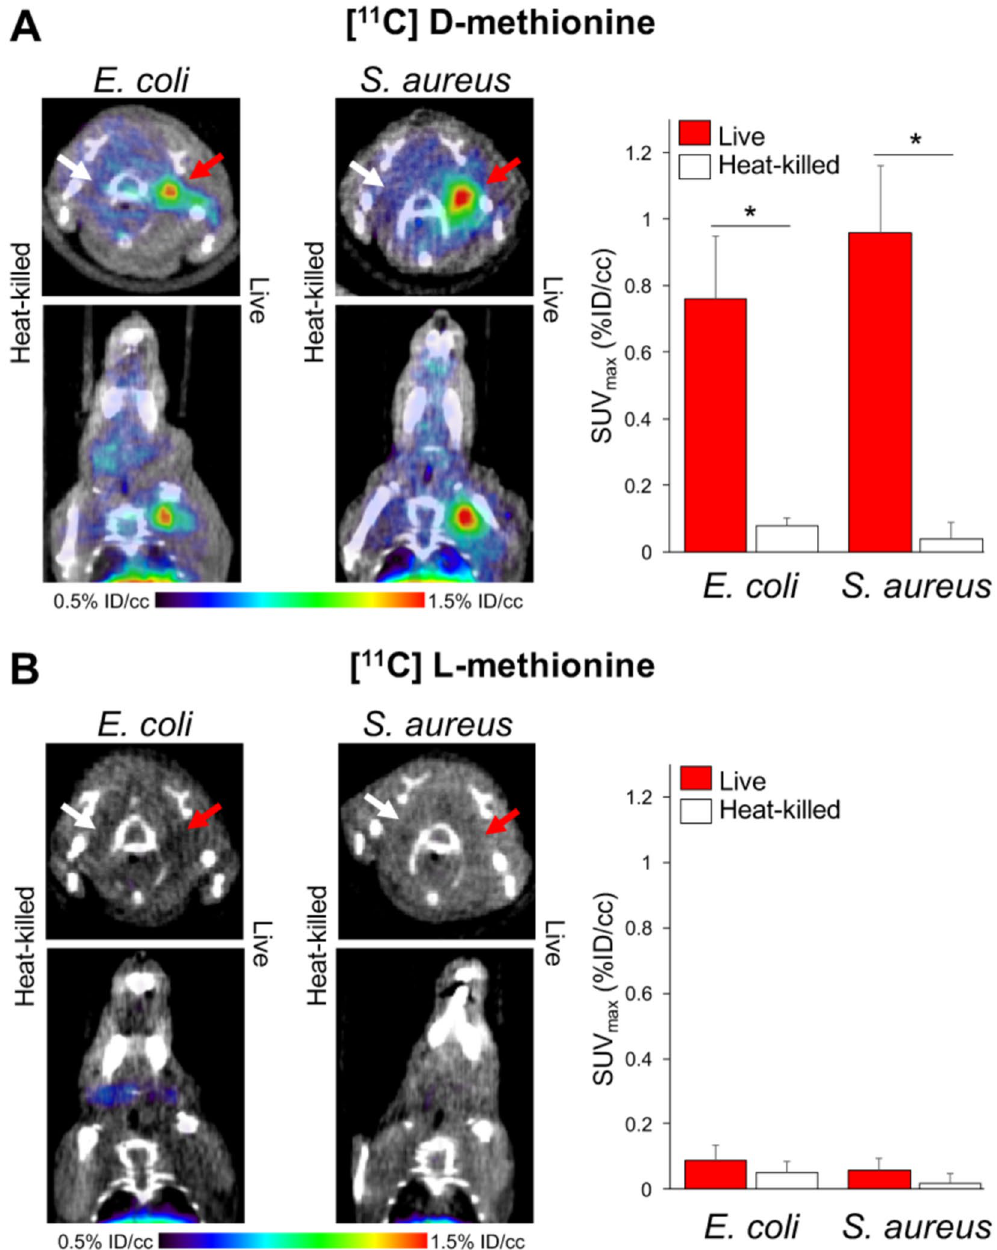
Figure 4. In vivo studies using [ 11 C] D-Met and [ 11 C] L-Met a murine myositis model (n = 4 for each condition studied). In all cases the site of live bacterial inoculation is denoted by a red arrow, while the site of 10X heat- killed bacterial inoculation is denoted by a white arrow. ( A ) [ 11 C] D-Met studies in E. coli and S. aureus -infected animals. Representative images show marked uptake in areas corresponding to live bacterial injection (left deltoid), in contrast to sterile inflammation (right deltoid) and normal muscle. ROI analysis of E. Coli and S. aureus [ 11 C] D-Met cohorts, corrected using normal muscle uptake. ( B ) [ 11 C] L-Met studies in E. coli and S. aureus . There is no observable difference in signals from the left (infected) and right (sterile inflammation) deltoid muscles. ROI analysis of E. Coli and S. aureus [ 11 C] L-Met cohorts, showing no significant difference in accumulation between infection and sterile